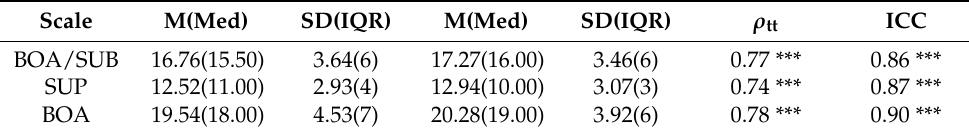
Table 7. Test–retest results for the BPQ-22 scales (data from the second sample, n =